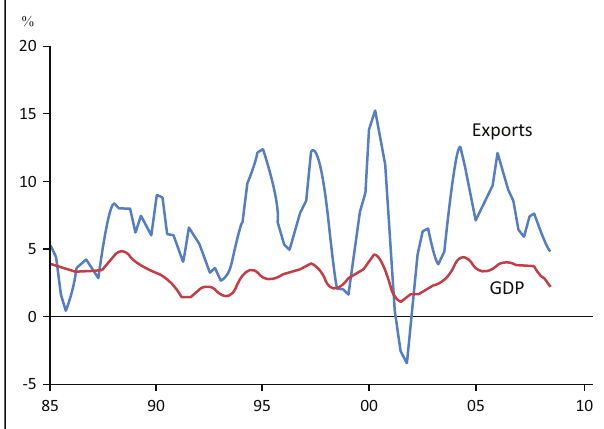
FIGURE 2: Growth rate of global exports plotted against global gross domestic product growth